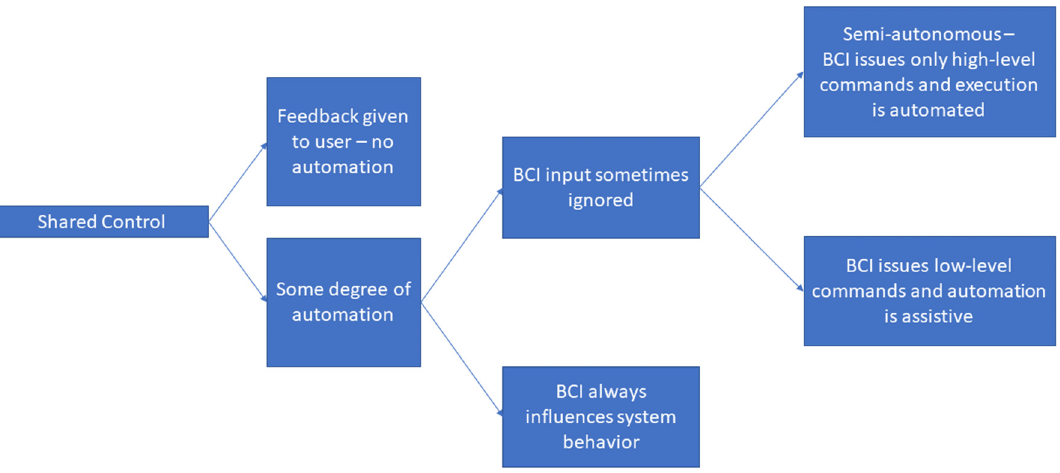
Figure 4. A taxonomy of the shared-control approaches proposed in the reviewed